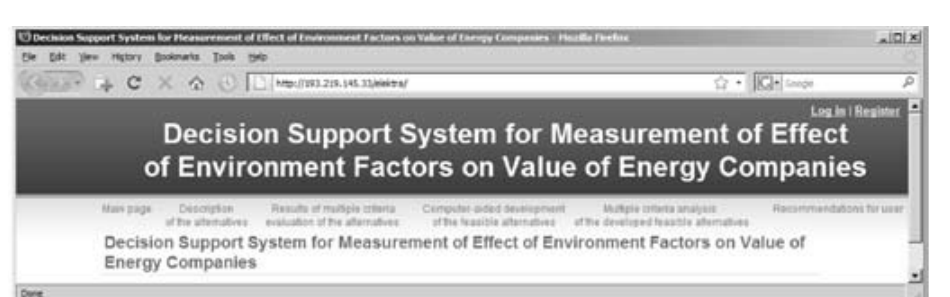
Fig. 8. The main window of ESIAPVN-DS